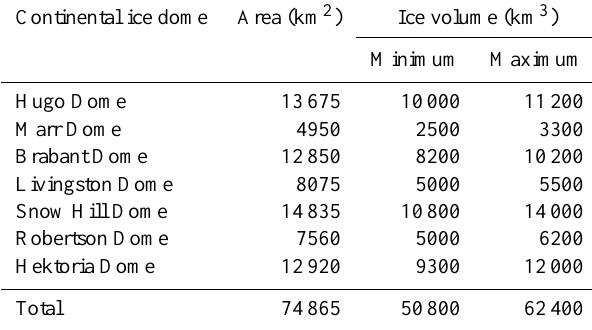
Table 2. Continental-shelf domes estimated area and minimum and maximum estimated ice volumes using the simple Bodvarsson– Vialov model (Bueler et al.,